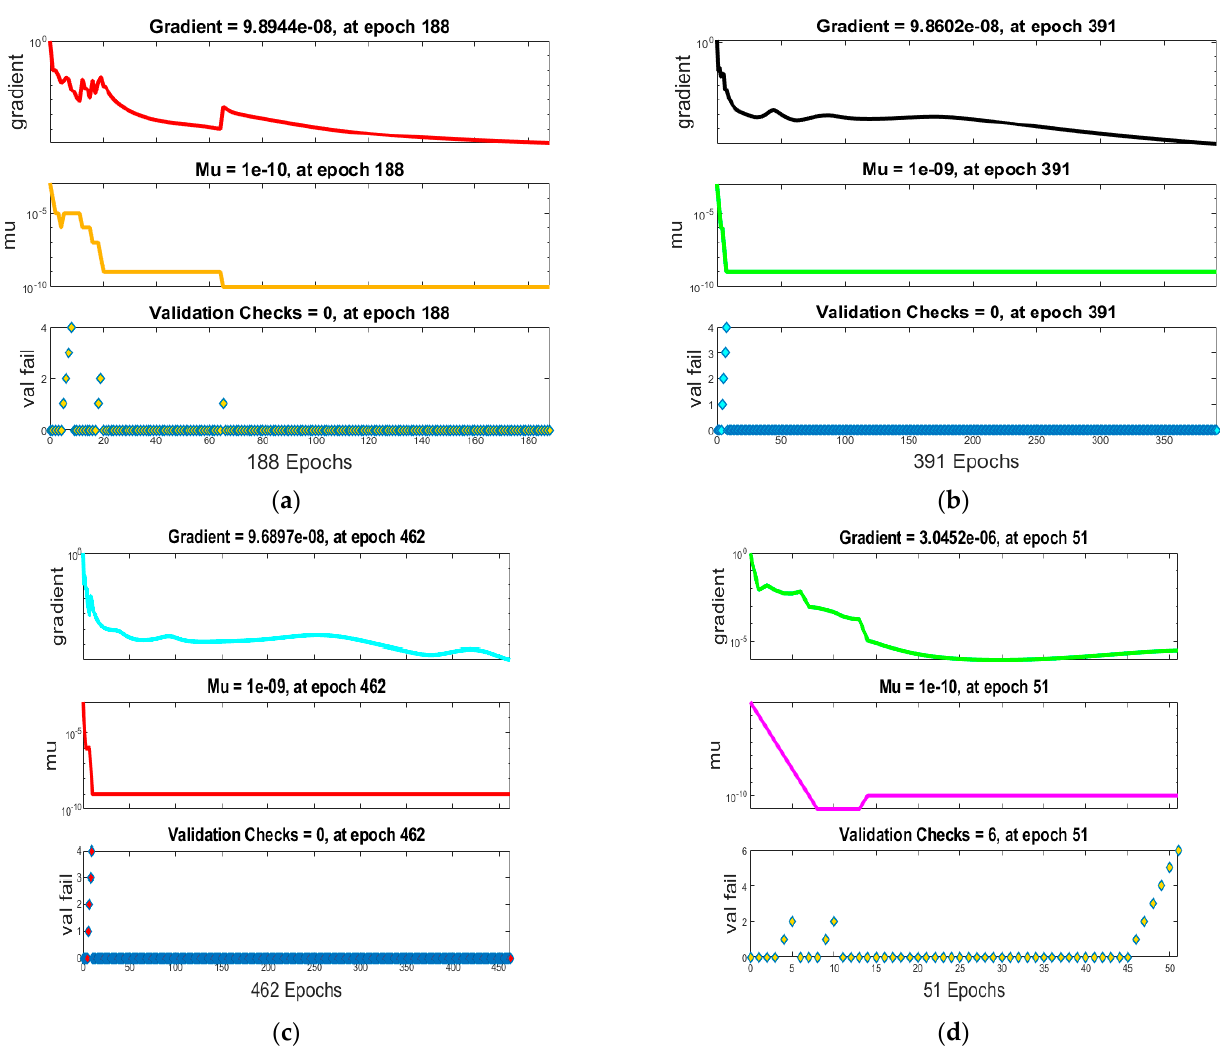
Figure 4. ( a – d ) Algorithm dynamics of ANNLMB to solving heat transfer of spinning nanofluid.